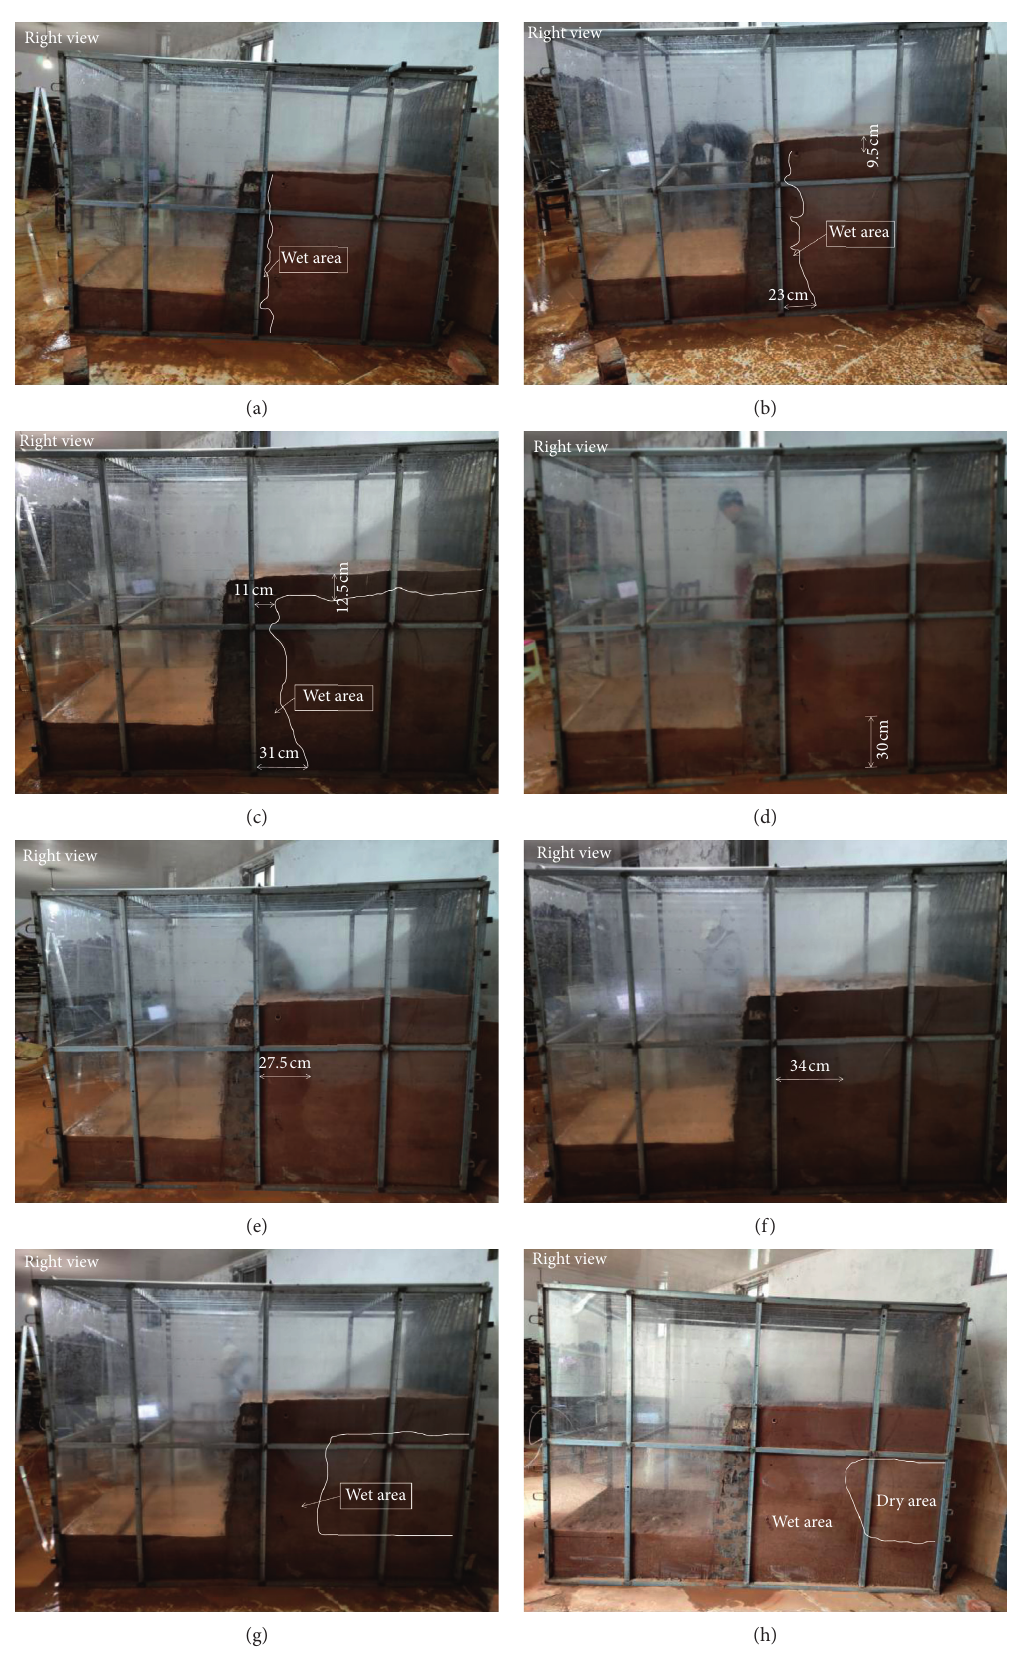
Figure 9: Rainwater infiltration behind the retaining wall within the first year. (a) First rainfall lasted for 20 minutes. (b) First rainfall lasted for 60 minutes. (c) First rainfall lasted for 120 minutes. (d) 5.2 hours after the first rainfall. (e) Second rainfall lasted for 120 minutes. (f) 5.2 hours after the second rainfall. (g) Third rainfall lasted for 120 minutes. (h) 70 hours after the third